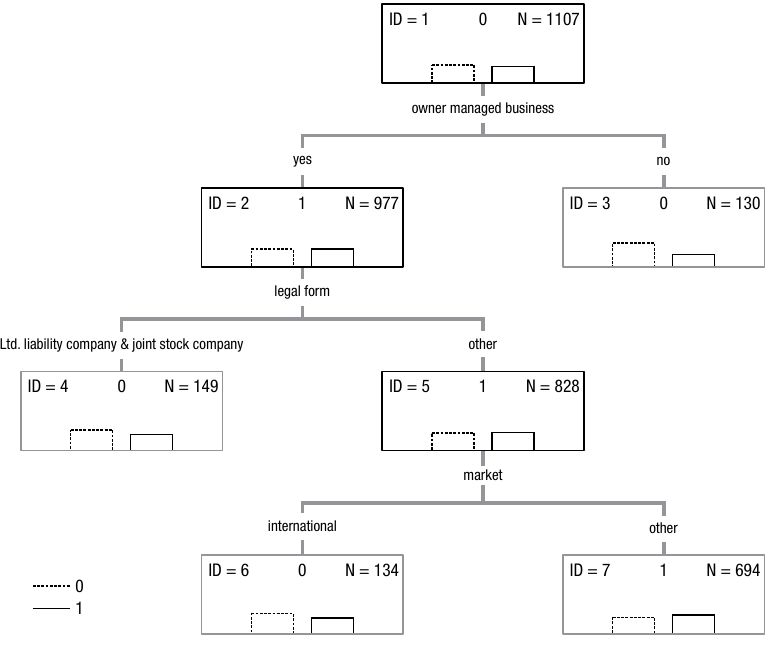
Fig. 2. Classification and regression tree for fall in profits number of shared hiches: 3, number of final hiches: Table 5. Predictive value for the regression tree (for the model of firm-specific variables resulting in the decrease of SME profits during the period of reduced economic activity)